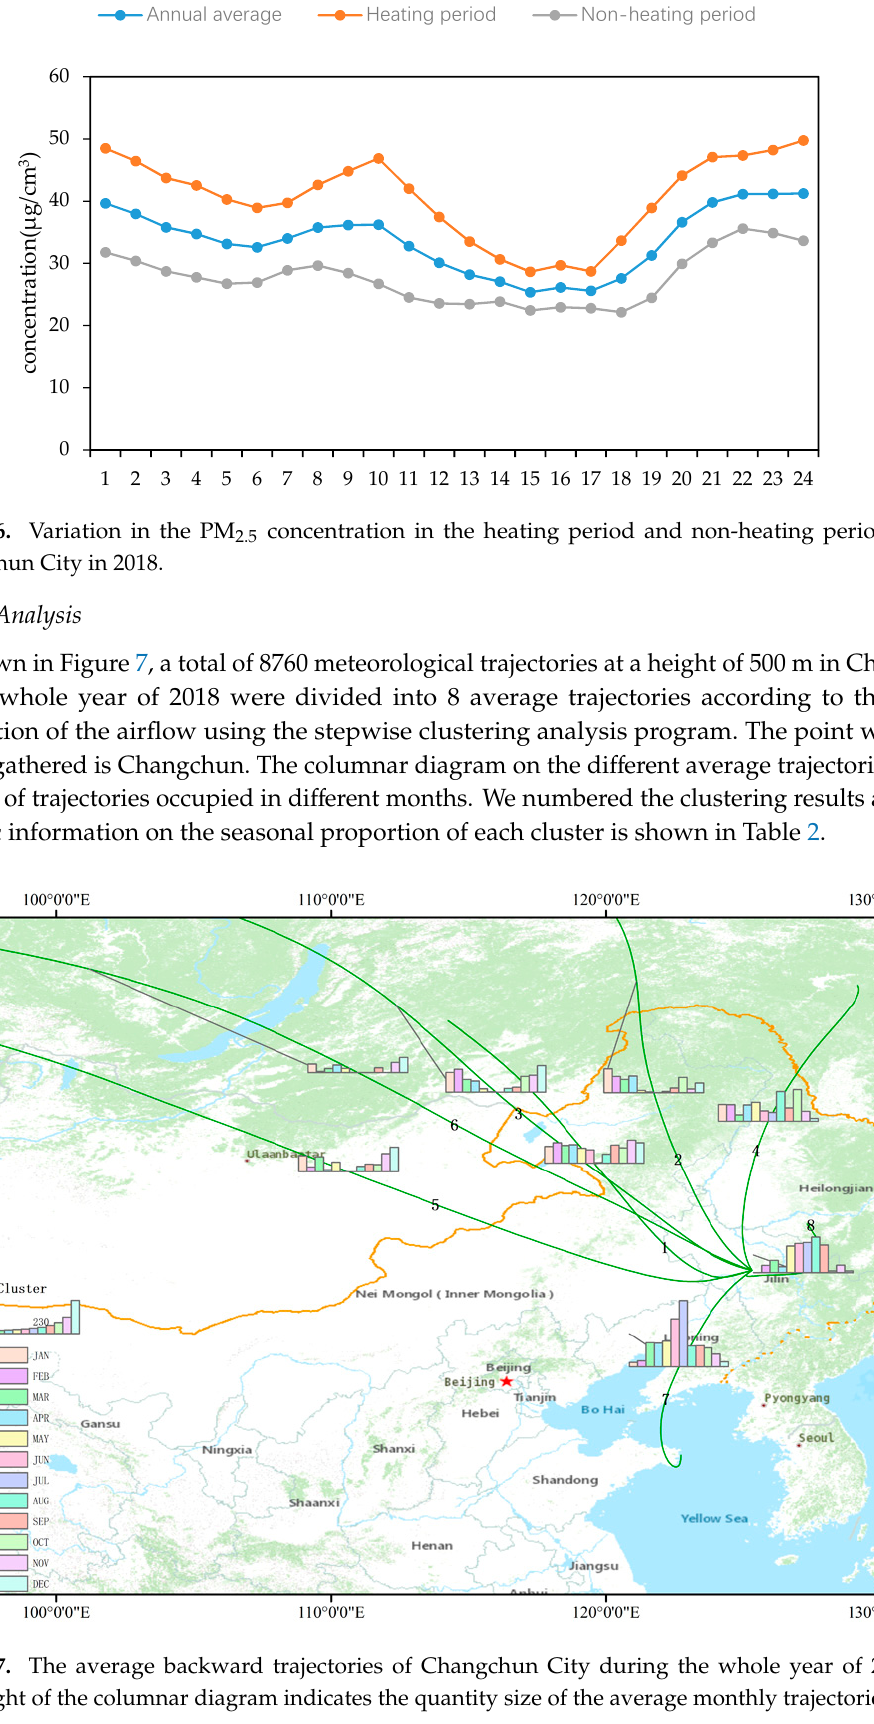
Figure 5. Variation in the hourly concentration of the PM 2.5 concentration in the four seasons of Changchun City in 2018.